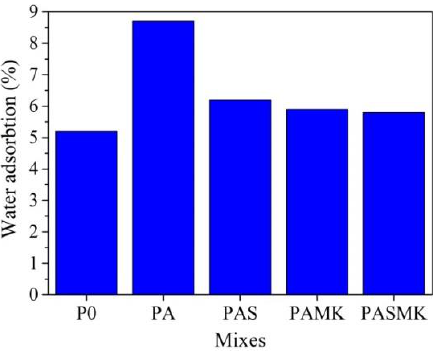
Figure 12. Variation in the water absorption by samples with different fillers and pozzolanic addi- tives.